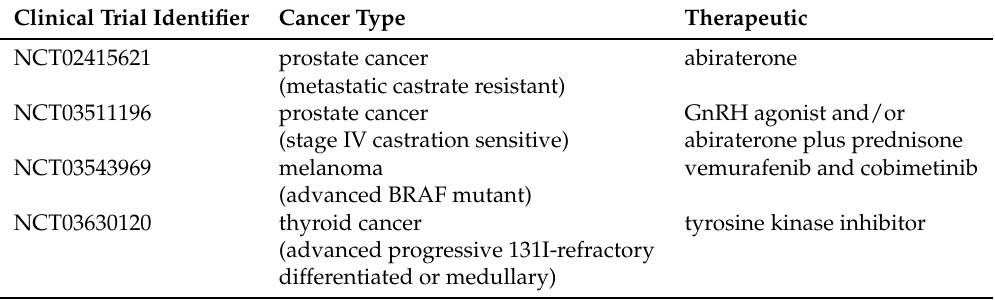
Table 1. Examples of clinical trials for adaptive